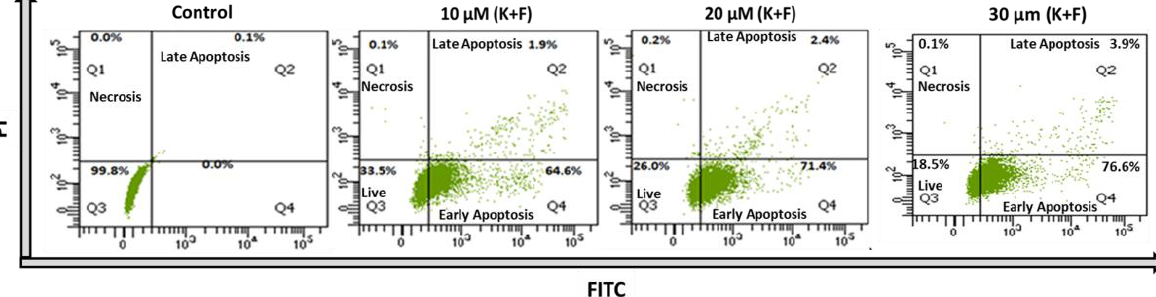
Figure 3. Annexin V-FITC/PI-positive MDA-MB-231 cells 24 h after treatment with 10, 20, and 30 µ M (K + F) according to flow cytometry showing different stages of the cells.